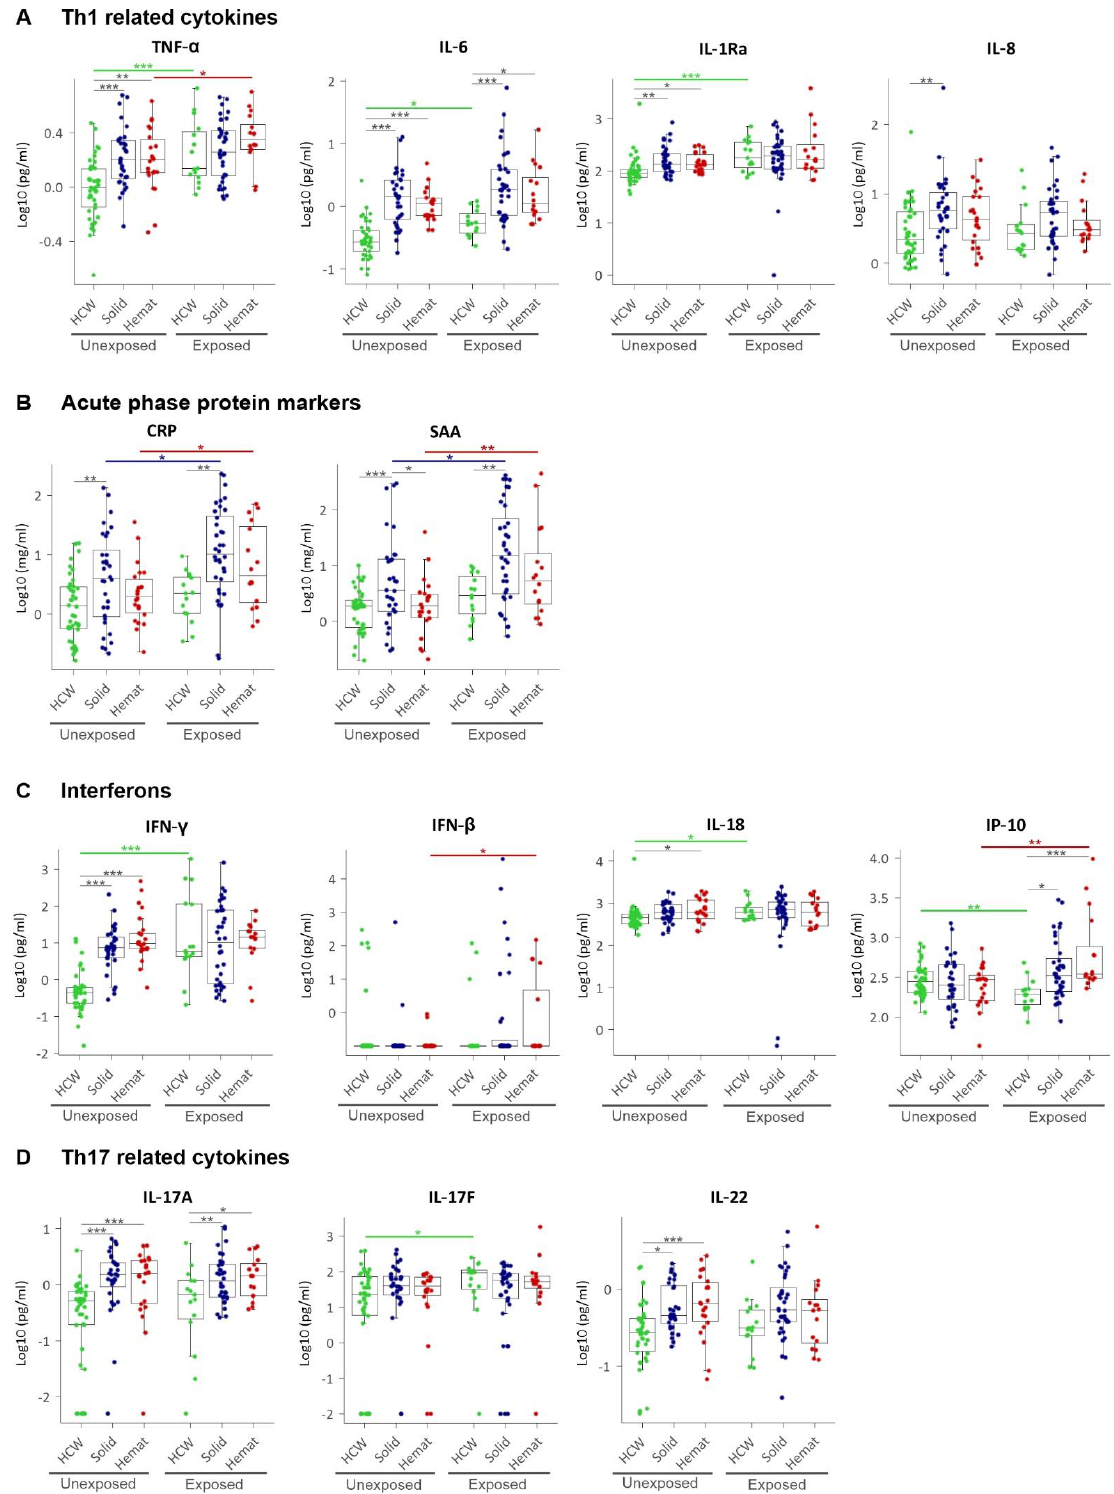
Figure 3. Plasma levels of pro-inflammatory CCGs as ( A ) Th1 related cytokines, ( B ) acute phase proteins, ( C ) interferons and interferon-related cytokines, and ( D ) Th17 related cytokines. HCW, health care workers (green); solid, patients with solid tumours (blue); hemat, patients with haematological malignancies (red). Each dot represents the sample closest to exposure in the case of exposed patients, and an average of multiple timepoints, when available, for unexposed patients. * p < 0.05, ** p < 0.01, *** p <